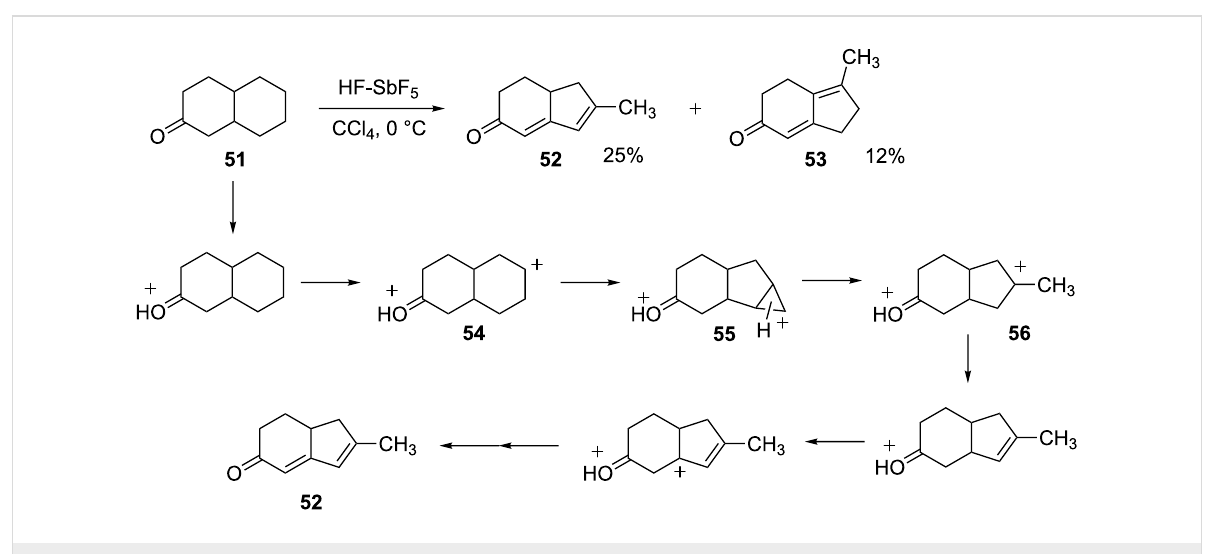
Scheme 12: Isomerization of 2-decalone ( 51